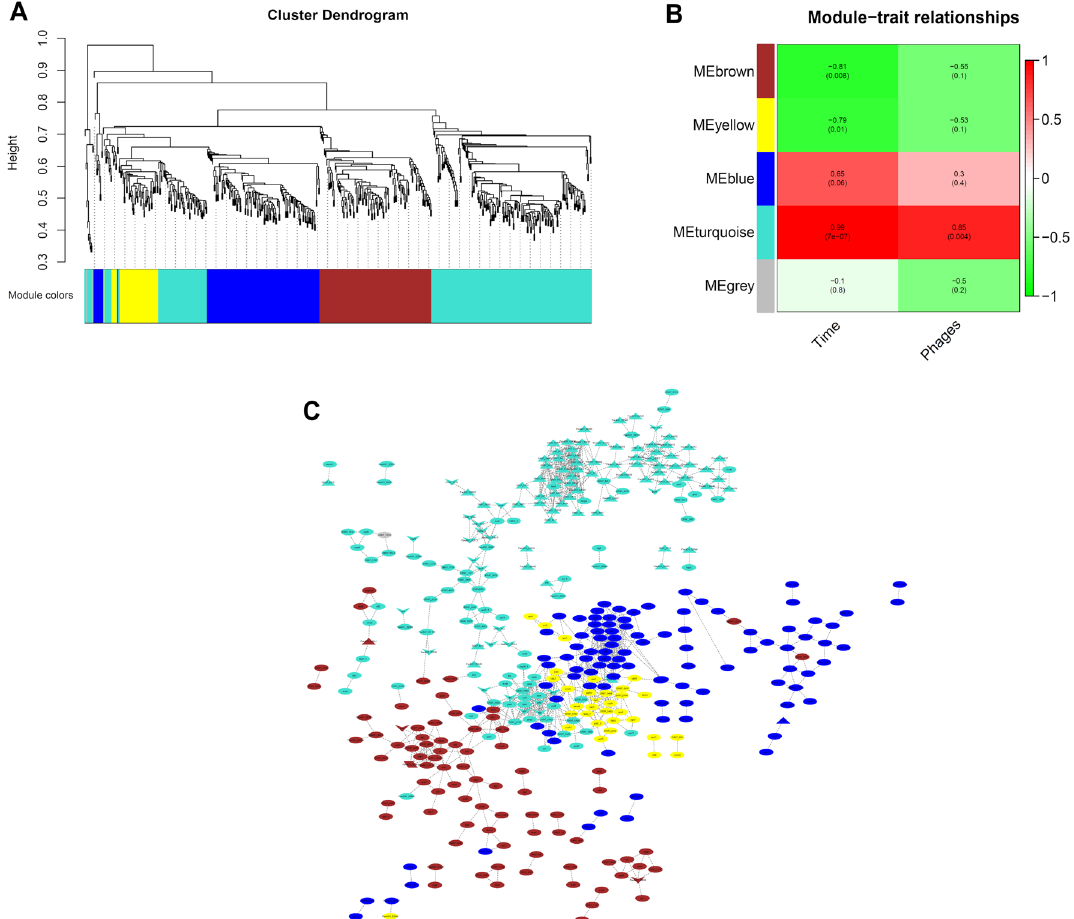
Figure 5. Co-expression analysis to identify modules of genes and the data-driven co-expression network in PaeAG1 after Ciprofloxacin treatment. ( A ) Modules identification (clusters by colors) using correlated expression genes (along times 0, 2.5 and 5 h) and clustering analysis after WGCNA was implemented. ( B ) Association of modules to traits, showing relations between turquoise and blue modules with exposure time to antibiotic and phages induction. ( C ) Data-driven co-expression network using correlation of gene expression by WGCNA analysis (correlation > 98.5%). A total of 388 DEGs were found to be connected, with a total of 1,073 edges. Only correlated genes are shown. More details in supplementary Figure S3A. Phages genes, virulence factors and antibiotic resistance genes are represented as triangles, arrowheads and rhomboids,